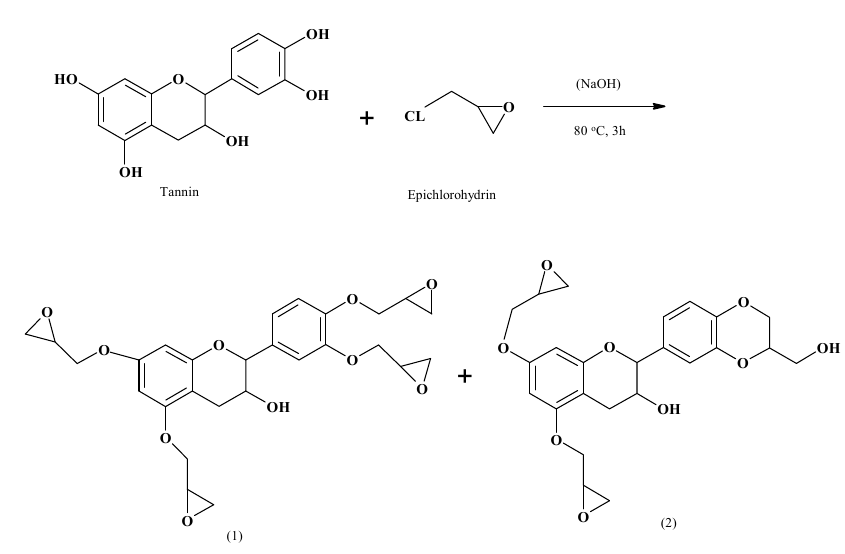
Figure 4. Reaction scheme for the epoxidation of tannin. Formation of epoxy groups on different sites of tannin’s flavonoid units.